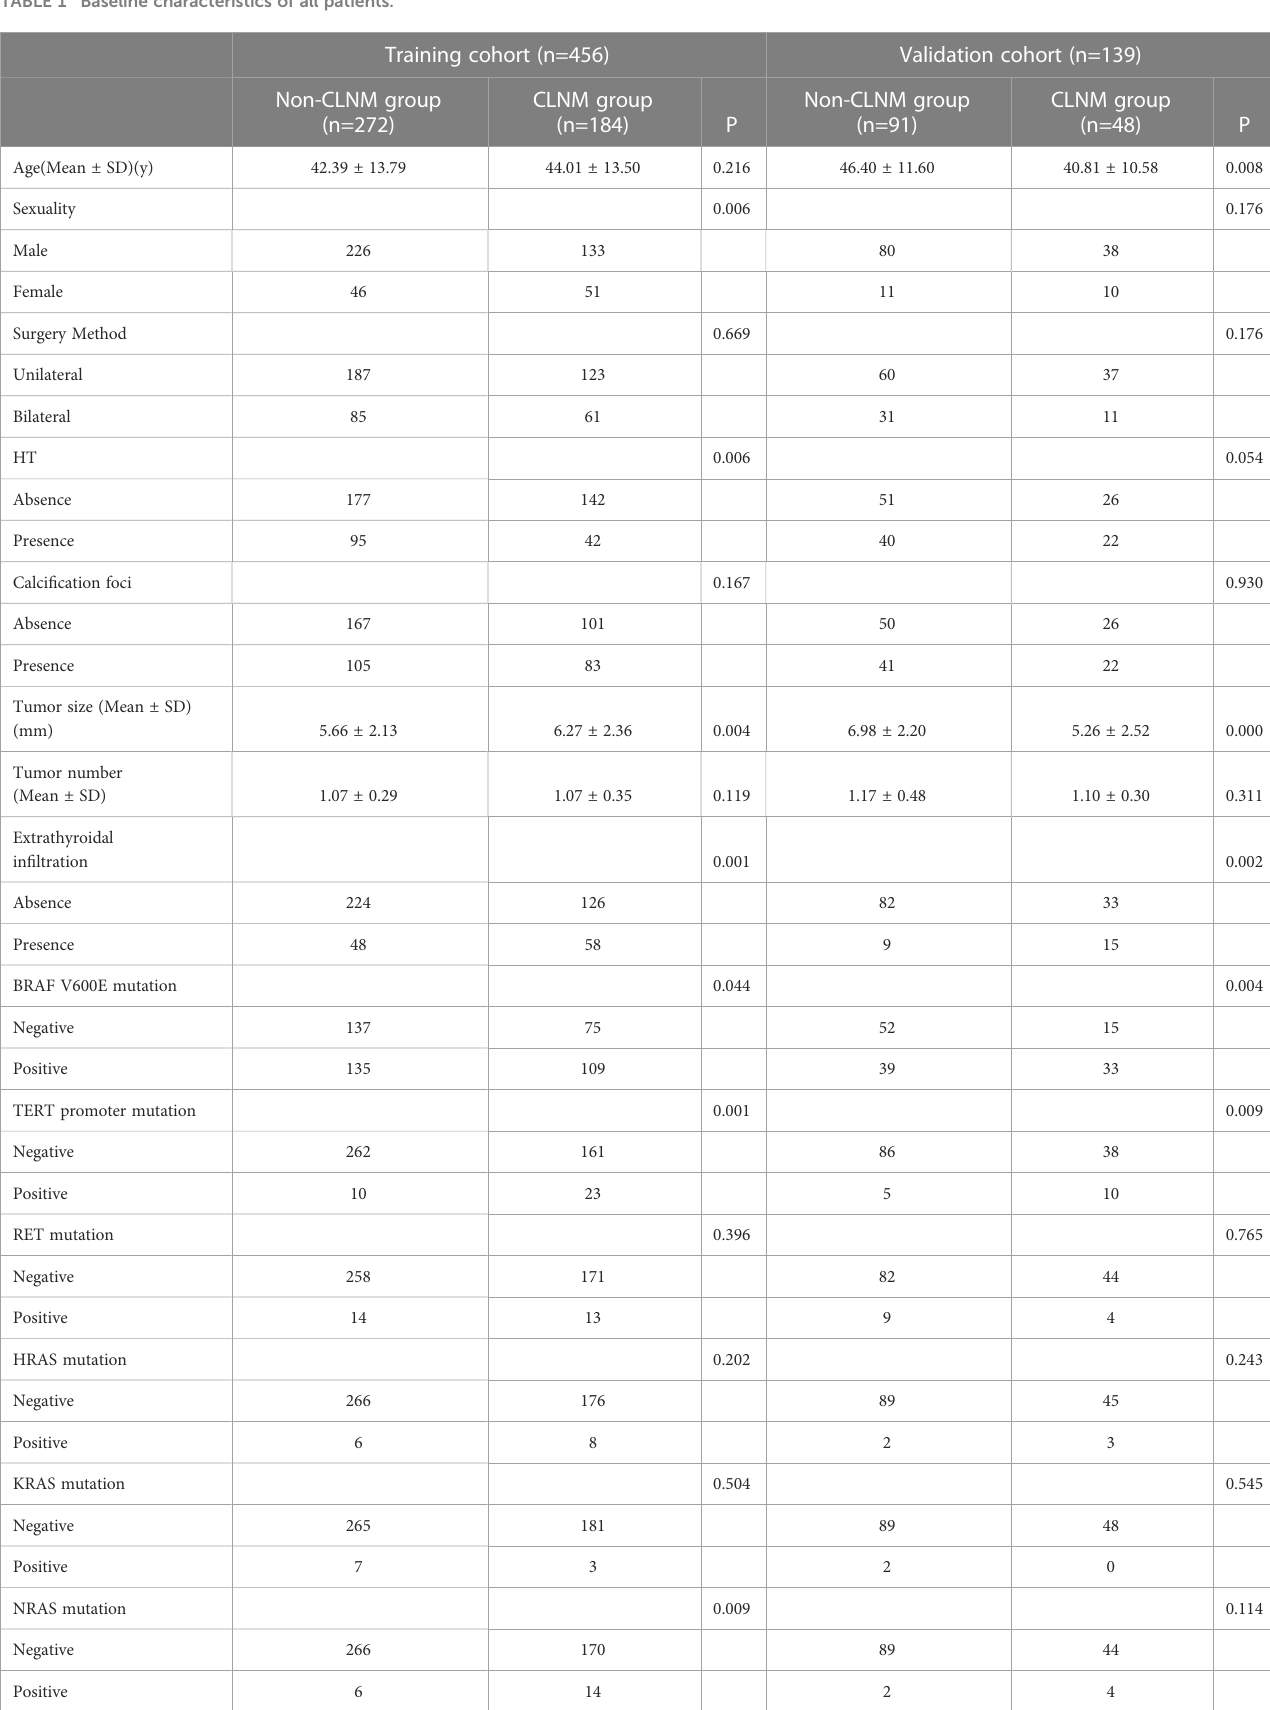
TABLE 1 Baseline characteristics of all